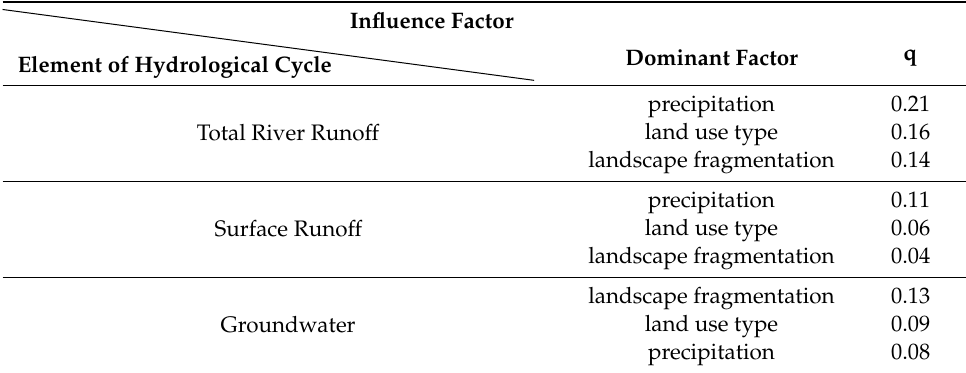
Table 3. The dominant factors and q values of the di ff erent element of hydrological